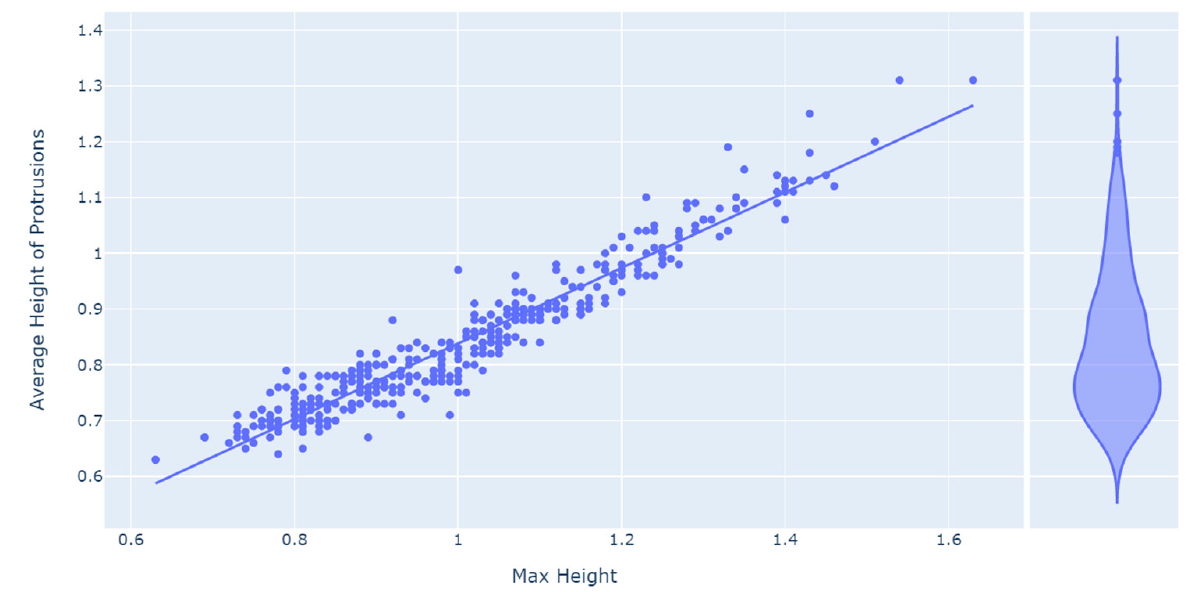
Figure 12. Scatter plot for max height and average height of protrusions.